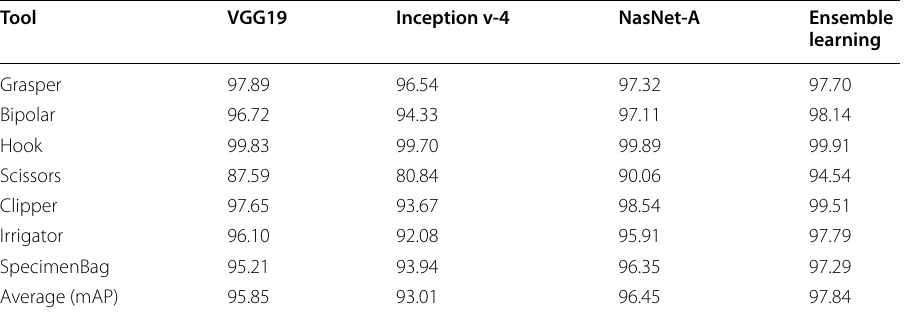
Table 2 Areas under the ROC curves per-class and the average mA z for each model Tool